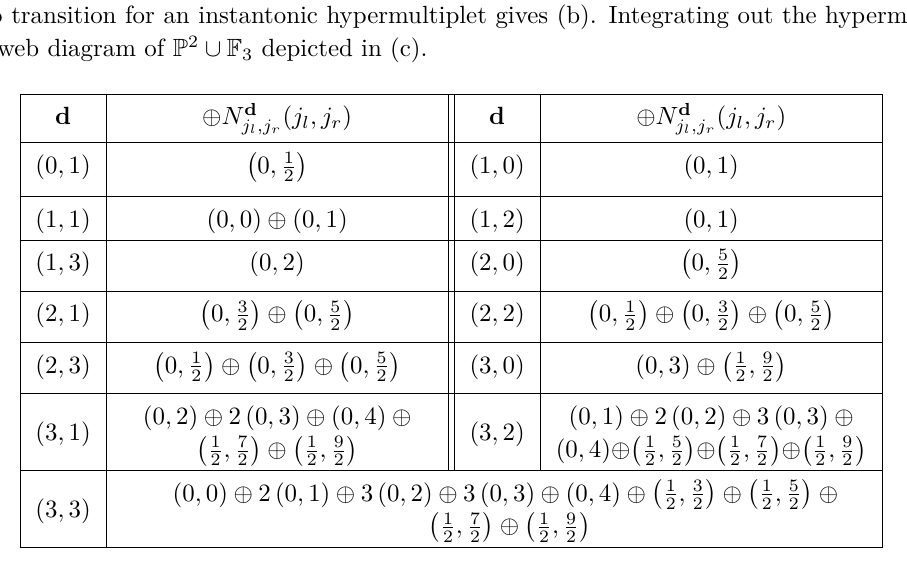
Table 25. BPS spectrum of P 2 ∪ F 3 for d i ≤ 3 . Here, d = ( d 1 , d 2 ) labels the BPS states with charge d 1 ‘ + d 2 f 2